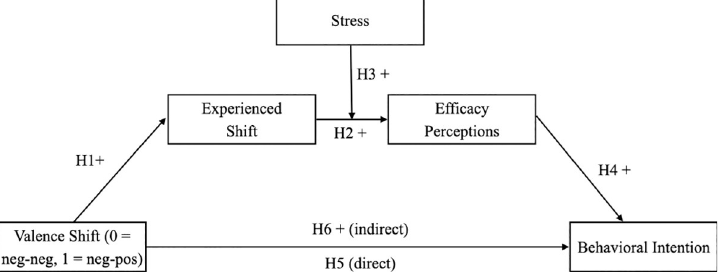
Fig 1. Effects of valence shift on behavioral intention mediated by experienced shift and efficacy perceptions and moderated by stress.